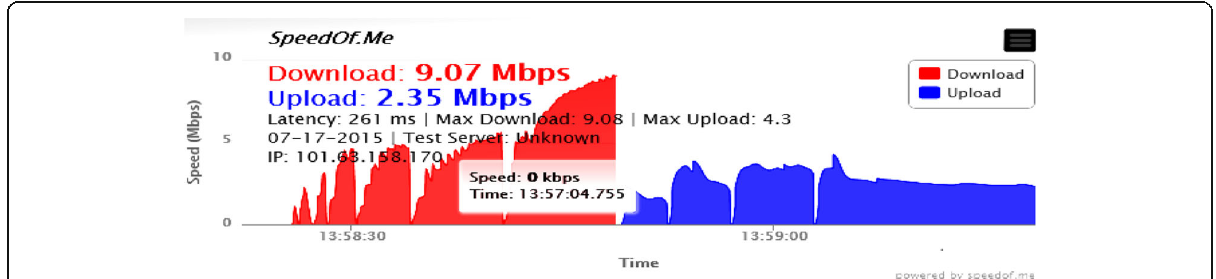
Fig. 1 Bit rate measurement on 4G hotspot devices. The bit rates were observed at client machine connected to the Internet using LTE 4G hotspot device of Airtel